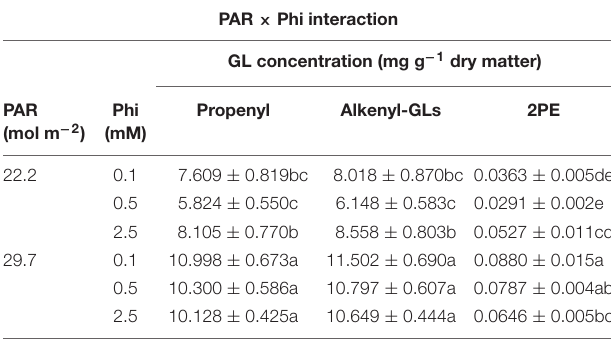
TABLE 2 | Mean daily photosynthetically active radiation (PAR), phosphate (Pi), and phosphite (Phi) affecting glucosinolate (GL) concentrations in B. campestris cv. Mibuna Early.